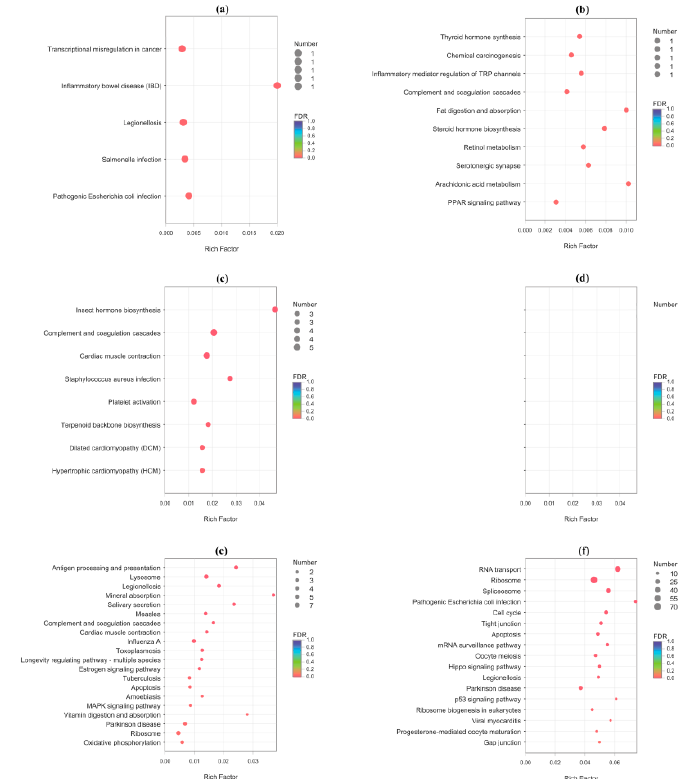
Figure 5. KEGG pathway enrichment of DEGs in Mated-1 h vs. Virgin-1 h group (( a ) upregulated DEGs; ( b ) downregulated DEGs), Mated-6 h vs. Virgin-6 h group (( c ) upregulated DEGs; ( d ) downregulated DEGs, no DEGs enriched), and Mated-24 h vs. Virgin-24 h group (( e ) upregulated DEGs; ( f ) downregulated DEGs). The size of the dot indicates the number of DEGs in this pathway, and the color of the dot corresponds to different q-value ranges. The top 20 pathways each from upregulated DEGs and downregulated DEGs of each group are shown.